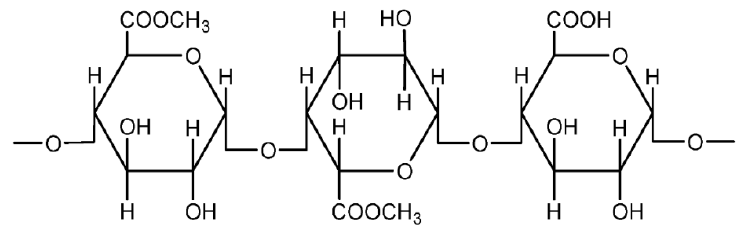
Figure 9. Representative unit of pectin.